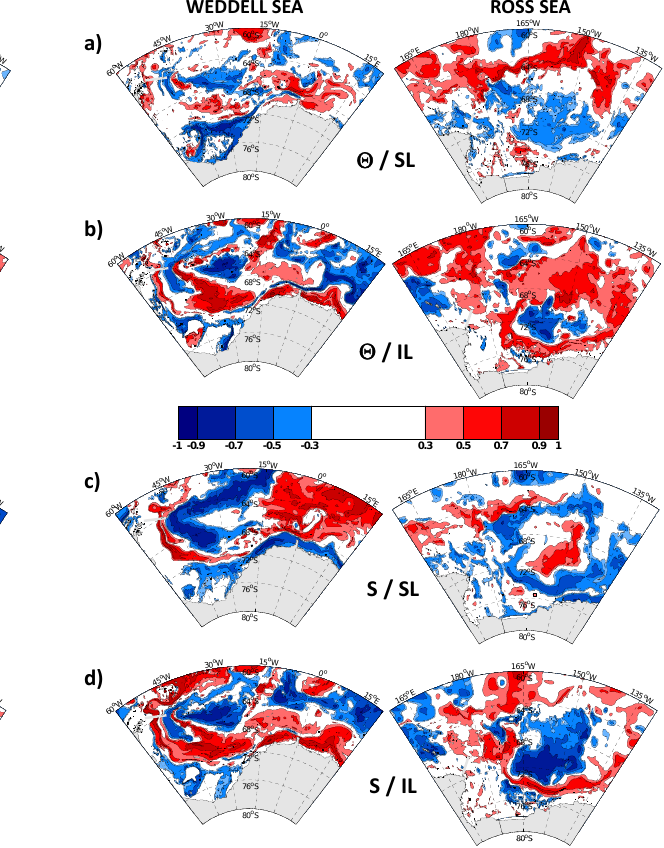
Fig. 19. Same as Fig. 18, but for correlations calculated for lag of five